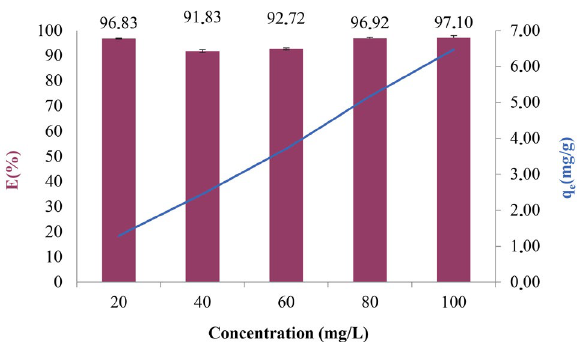
Figure 3. Effect of the initial RBV-5R dye concentration, standard deviations calculated from measurements from nine parallel results, where E-efficiency of adsorption, q e -maximum adsorption capaci- ties at equilibrium (C i = 20–100 mg/L, 1.5 g biomass, 160 µm, 700 rpm, pH = 6.0 ± 0.2, T = 20 ± 1 o C).